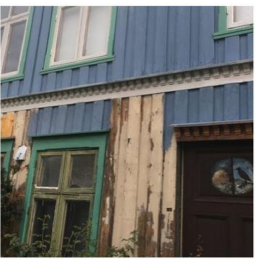
Figure 5. Deteriorating façade (NTNU).